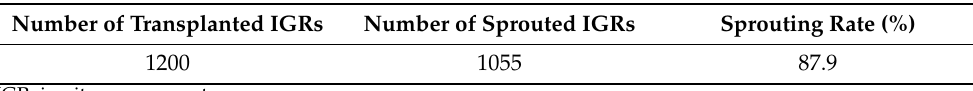
Figure 6. Acclimatization of in vitro grown roots (IGRs) in P. ginseng cv. Cheonryang. ( a ) IGRs before soil transfer, ( b ) Sprouted IGRs in a greenhouse, ( c ) Harvested 2-year-old IGRs after acclimatization for several months, ( d ) Transplantation of 2-year-old IGRs into the field. Scale bars, 1 cm. IGR, in vitro grown root. Table 7. Sprouting rate after acclimatization of IGRs derived from micropropagation of P. ginseng cv. Cheonryang.